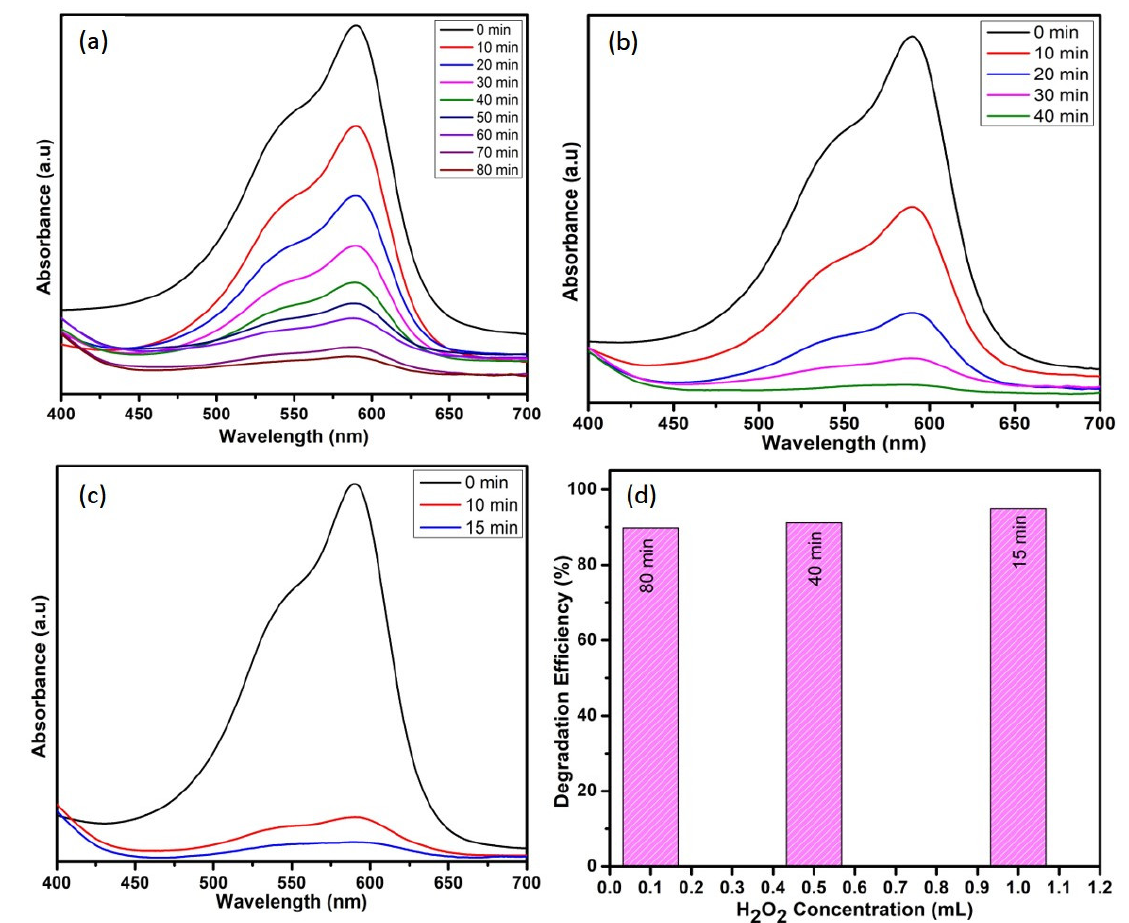
Figure 8. Effect of H 2 O 2 ( a ) 0.1 mL, ( b ) 0.5 mL, and ( c ) 1 mL and ( d ) comparison among the efficiencies of H 2 O 2 concentrations on degradation of CV dye.